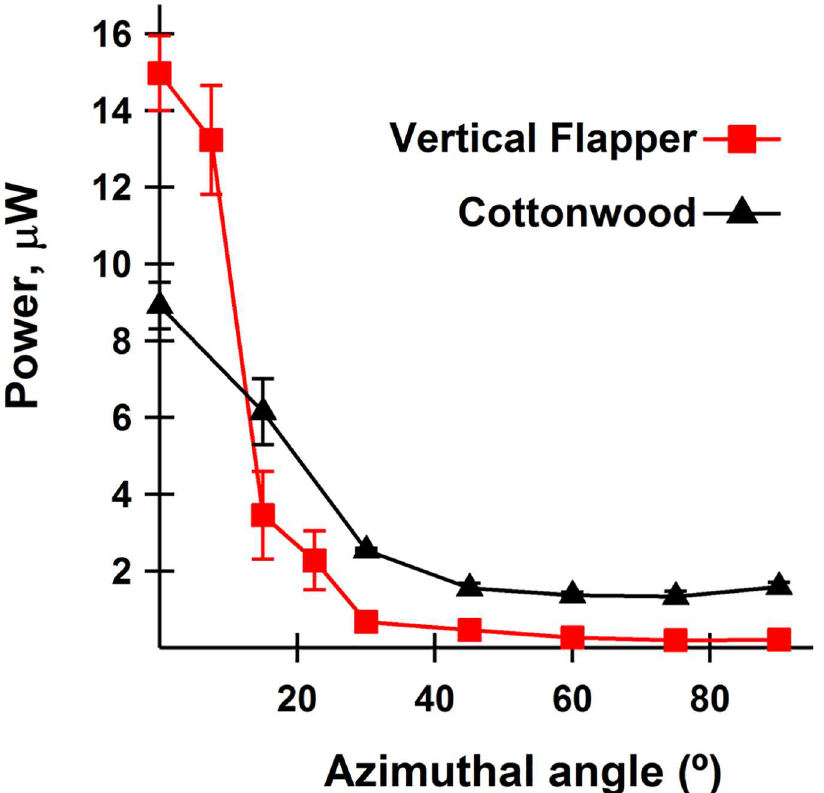
Fig 7. Directional sensitivity of power output from vertical flapping stalk and cottonwood leaf models. Power was maximal for both systems when PVDF petiole was orientededge-oninto wind (8.9 vs. 7.5 knots for flapper vs. cottonwood) and decayedwith increasein azimuthalangle. Max power was greater but decayedmore steeply for vertical flappingstalk. R L = 10 M Ω both